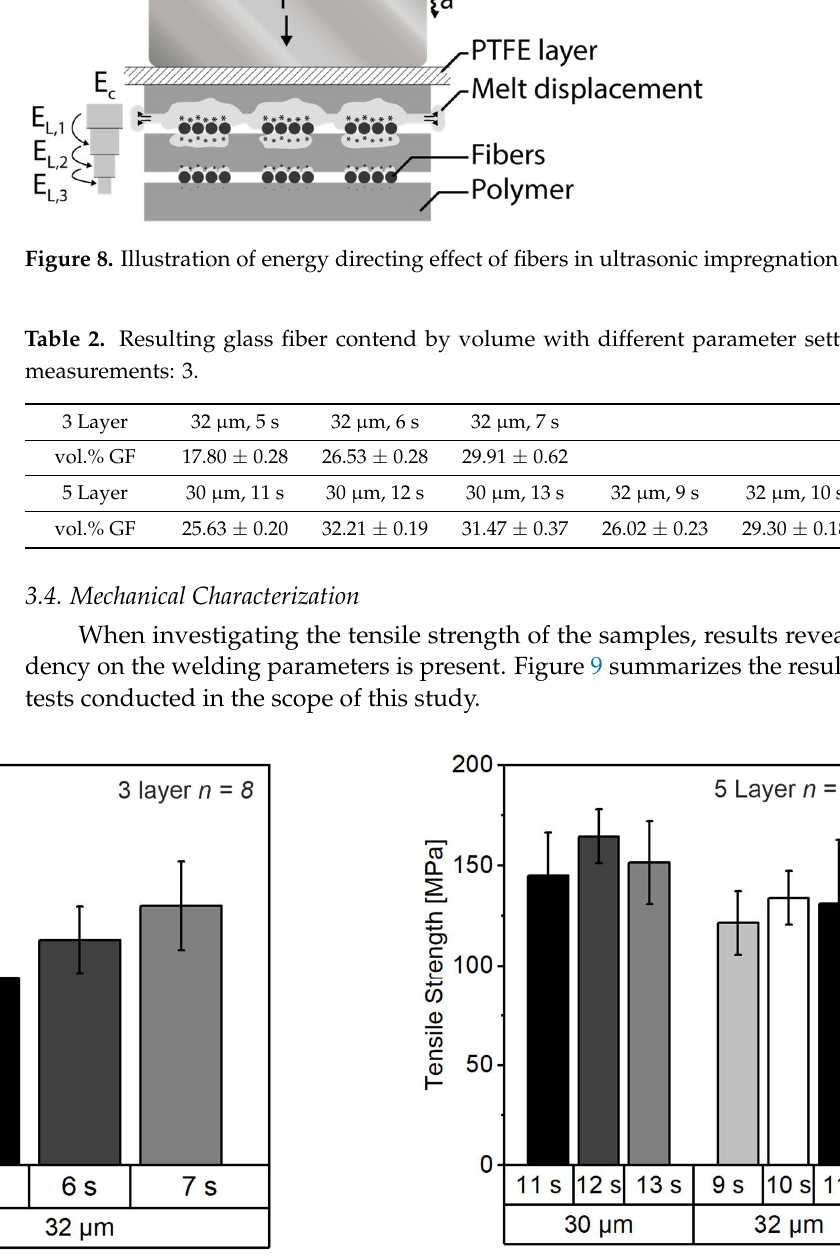
Figure 9. Comparison of tensile strength with different process parameters.